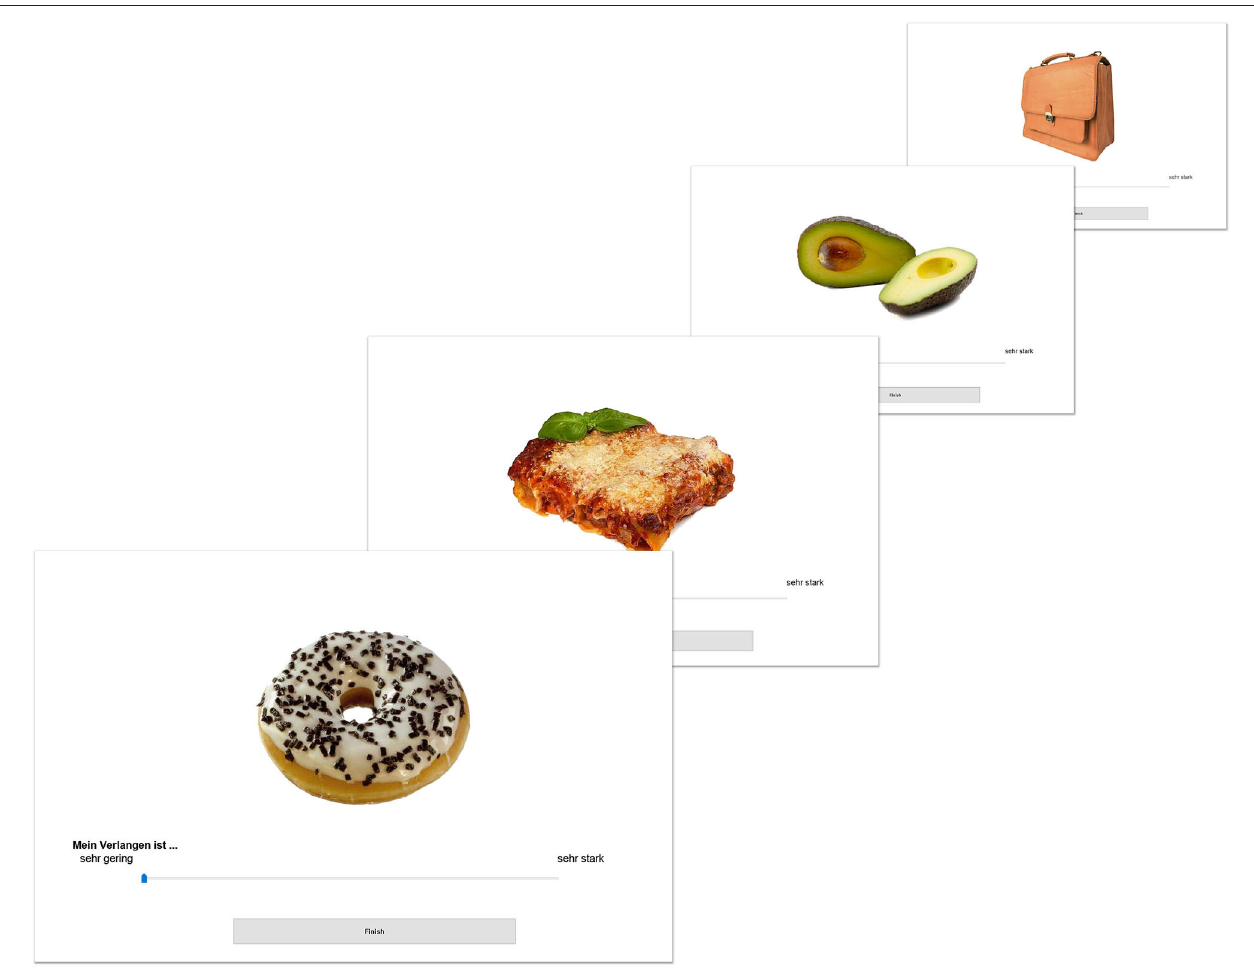
FIGURE 1 | Examples of stimuli (HFHS sweet, HFHS savory, LFLS, and Non-Food) in our paradigm to assess cue-induced food craving. Pictures from the food-pics database ( Blechert et al., 2014b).